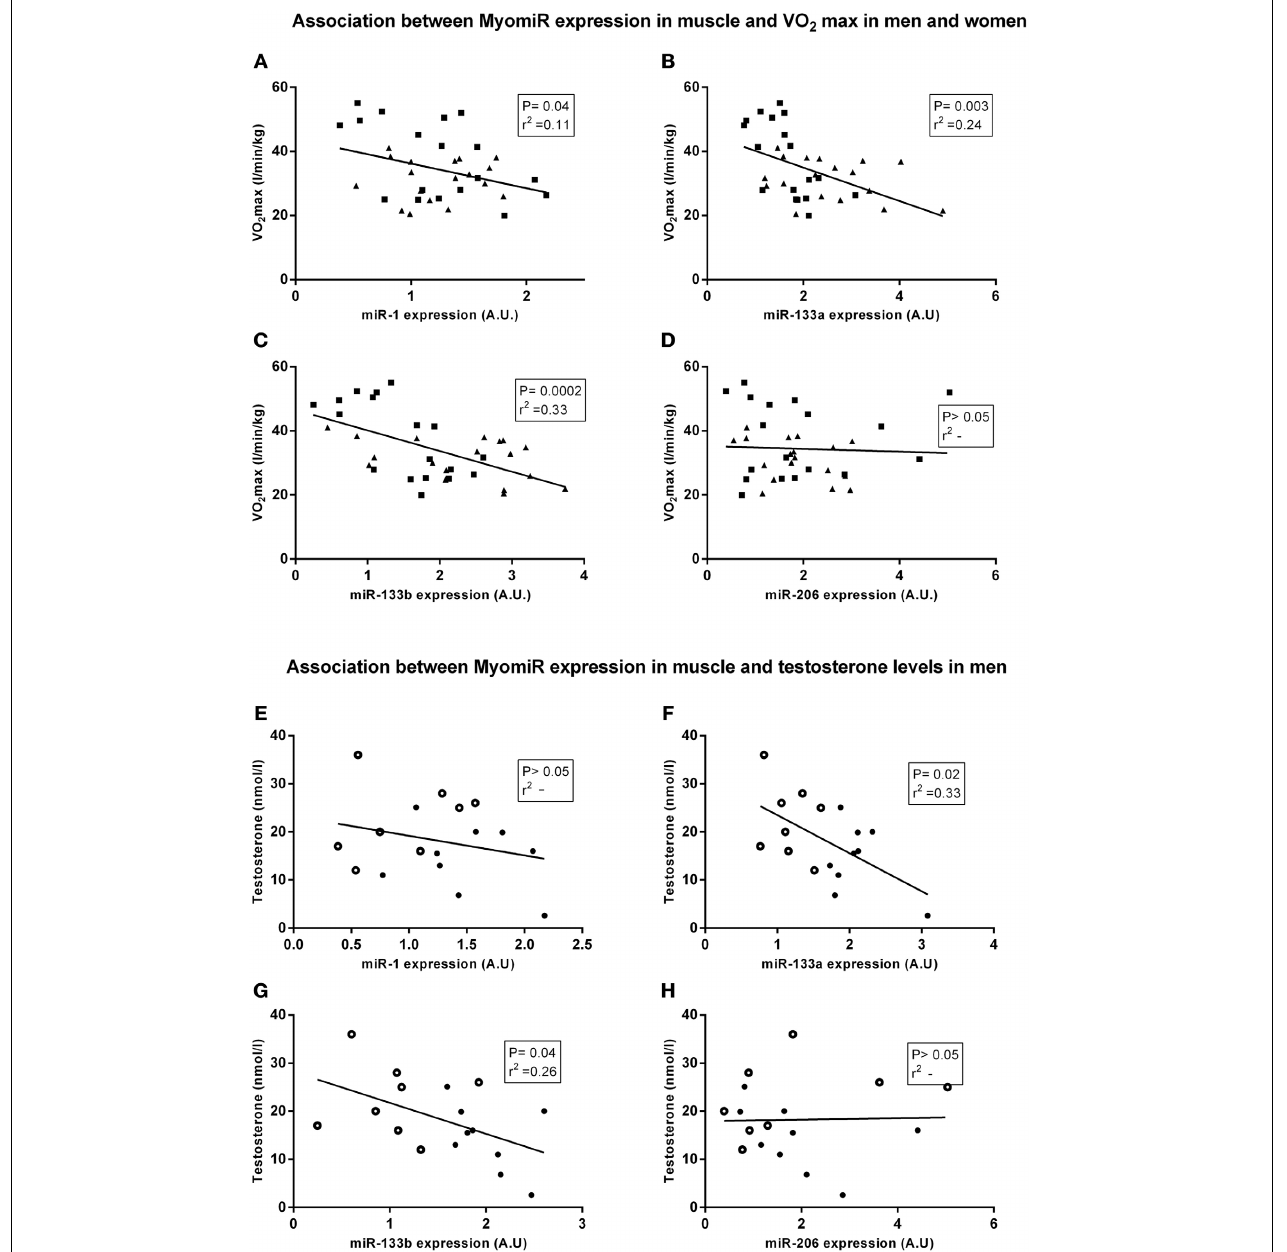
FIGURE 2 | Linear regression analysis between myomiR expression and physiological characteristics. The cohort described in Figure 1 was assessed for associations between muscular miRNA expression and physiological characteristics. In panel (A–D) are men symbolized ( (cid:2) ) and women are symbolized ( (cid:3) ). In panel (D,E) observations from elderly men are symbolized ( • ) and observations from younger men are symbolized ( (cid:5) ). miR-1, miR-133a, and miR-133b (A–C) were